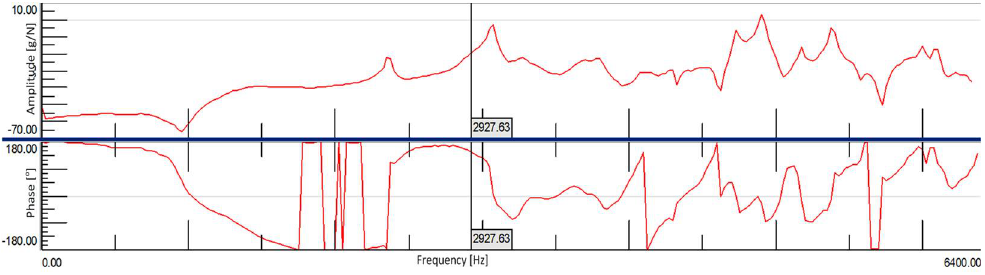
Figure 12. Theoretical first natural frequency of brick vibrations on the averaged FRF plot.